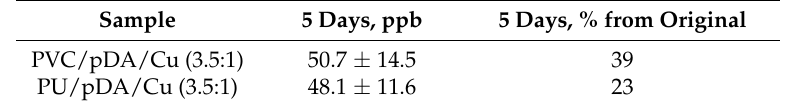
Table 3. Cumulative Cu leaching from the samples during 5 days determined by ICP-MS data.